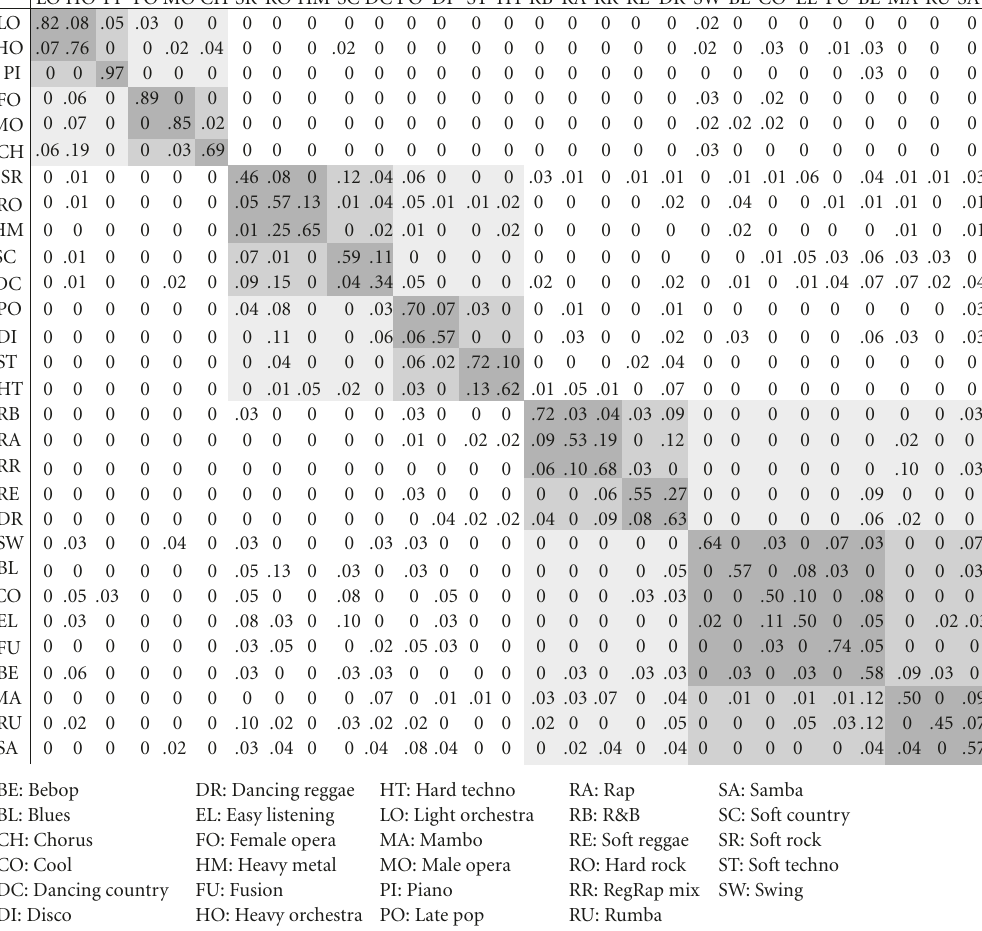
Figure 3: Confusion